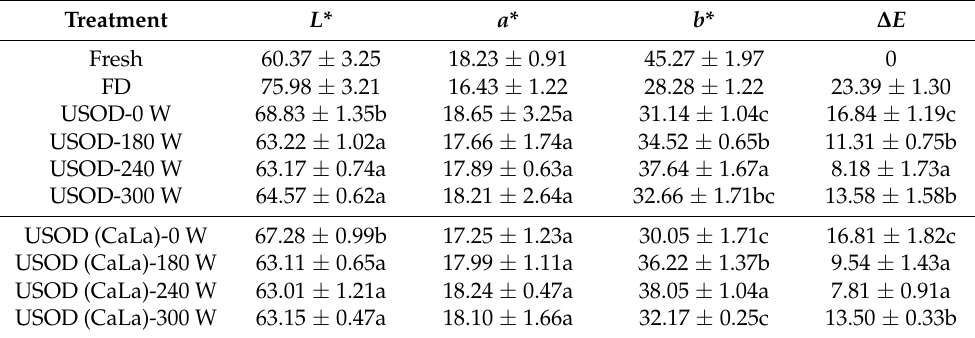
Table 1. L *, a *, b * and ∆ E of freeze-dried yellow peach slices with different treatments.